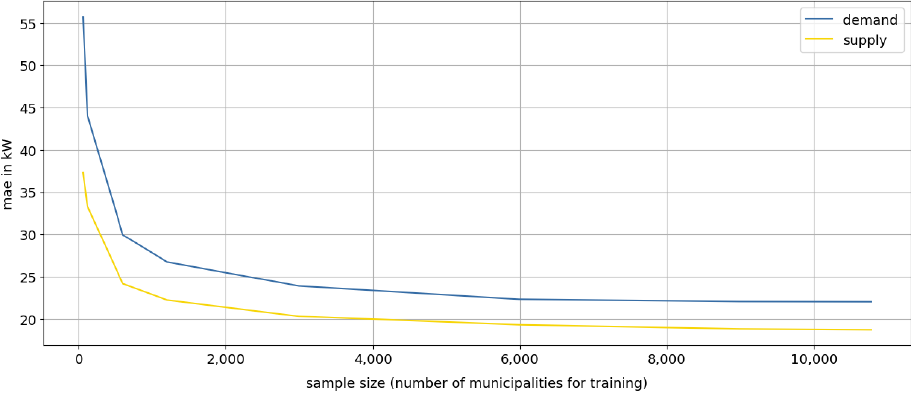
Figure 16. Model accuracy as a function of sampling size using TSA for training. The testing was conducted on the benchmark dataset.